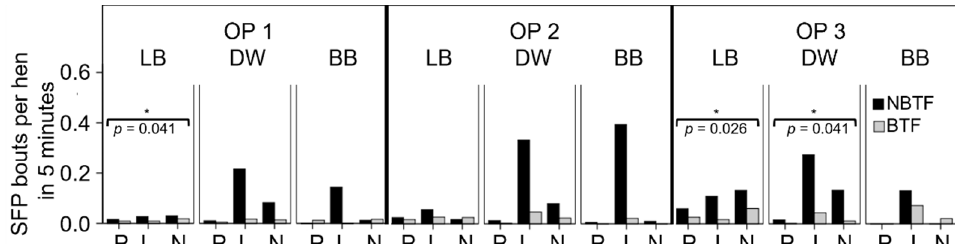
Figure 4. Occurrence of severe feather pecking (SFP) in beak-trimmed flocks (BTF) and non-beak-trimmed flocks (NBTF) in the functional areas, perches (P), litter area (L) and nest-box area (N), assessed in Observation Periods (OPs) 1–3. Statistical test: Mann–Whitney U-test, significant: (*) = p ≤ 0.050. The brackets indicate significant differences between BTF and NBTF. OP 1: 28th to 33rd week of life, OP 2: 42nd to 48th week of life, OP 3: 63rd to 68th week of life. LB = Lohmann Brown, DW = Dekalb White, BB = Bovans Brown. n = 12 cameras per OP and hybrid line.